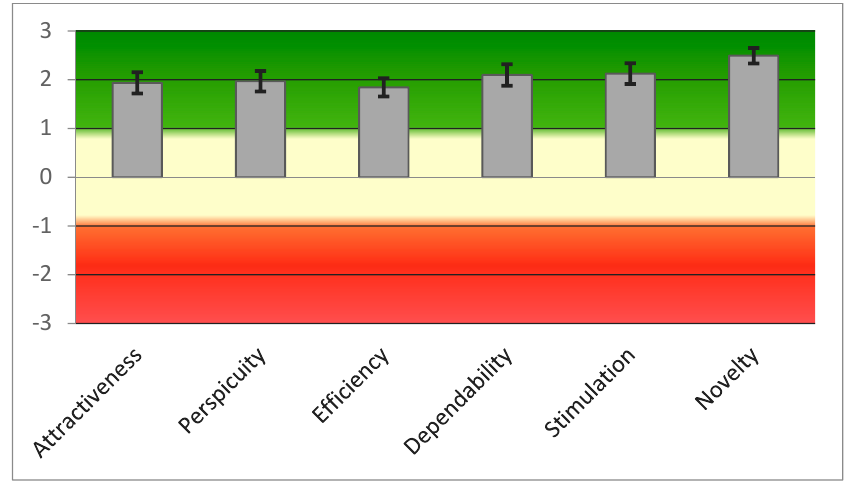
Figure 6. Graphic representation of scores of the six UEQ scales.